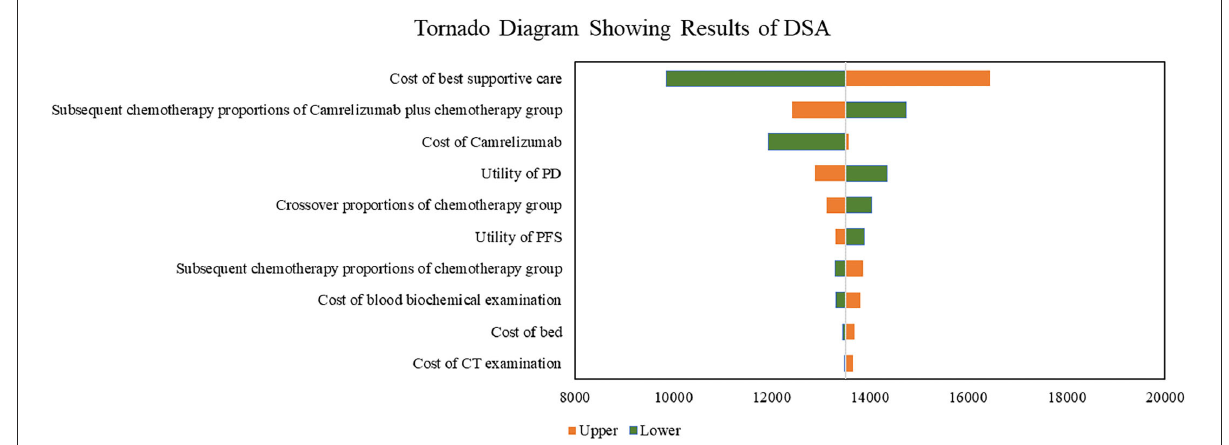
FIGURE1 Tornado diagram showing results of DSA. DSA, deterministic sensitivity; PD, progression disease; PFS, progression-free survival.